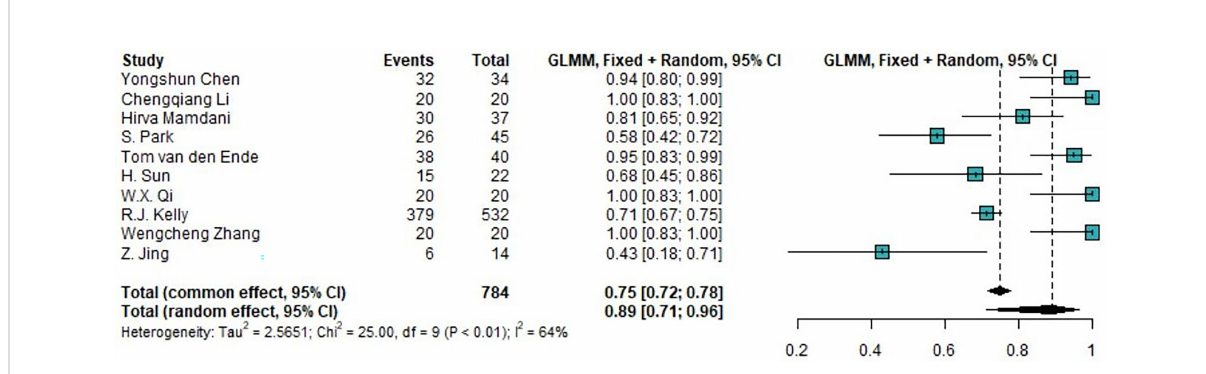
FIGURE 2 Forest plot of the incidence of any-grade treatment-related AEs. AEs, adverse events; GLMM, generalized linear mixed model.